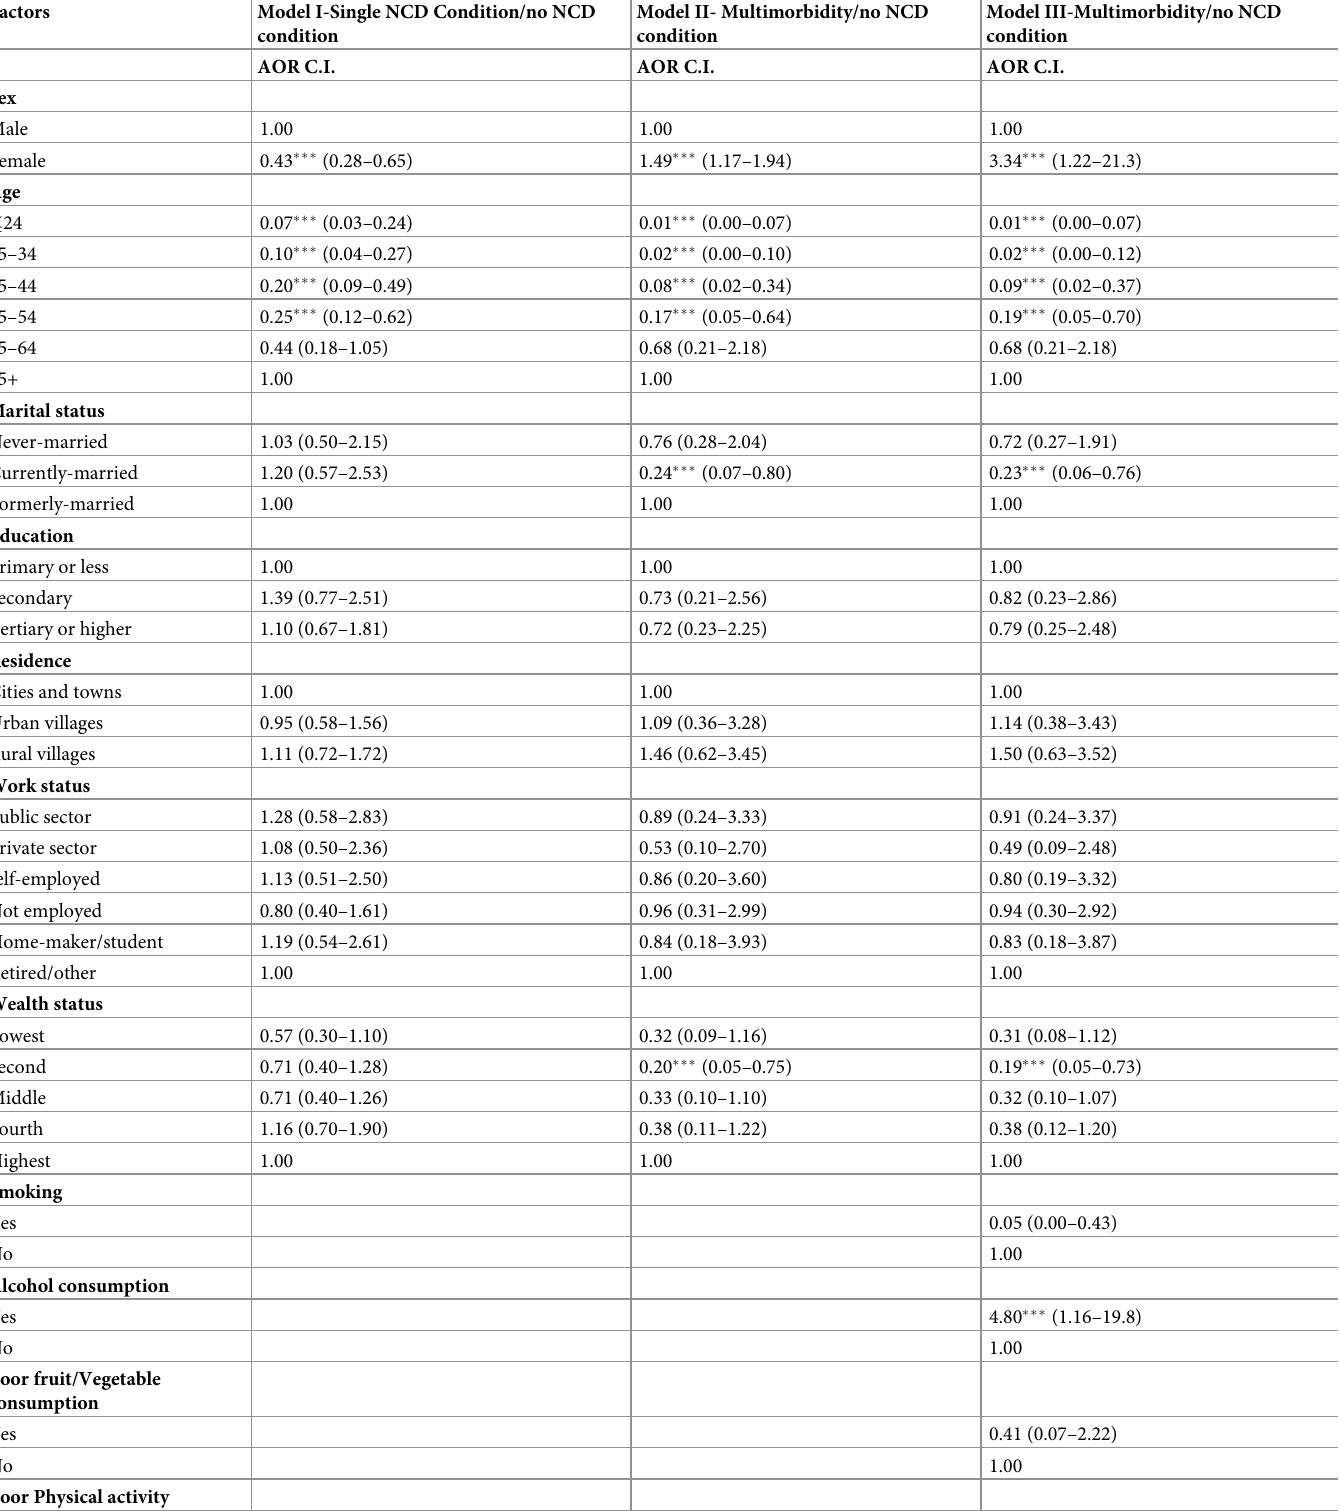
Table 3. Results of multinomial logistic regression analysis for the outcome-the presence of multiple (two or more) chronic NCDs over no NCD